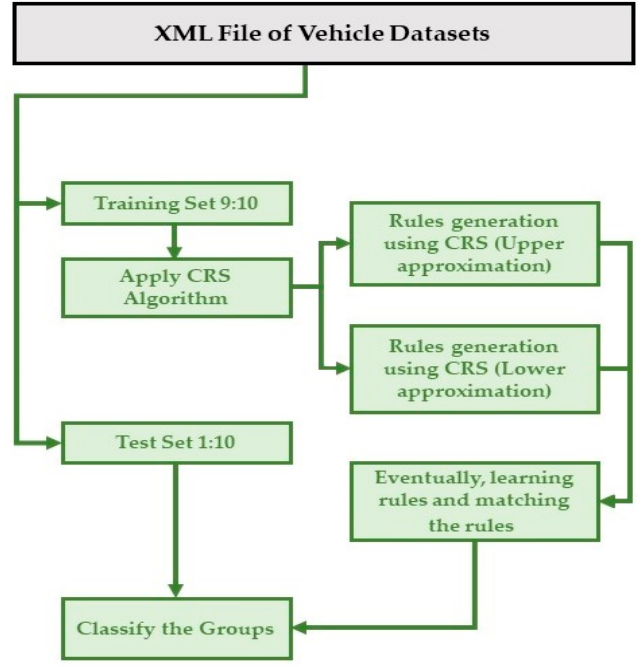
Figure 4. Rough set system model.